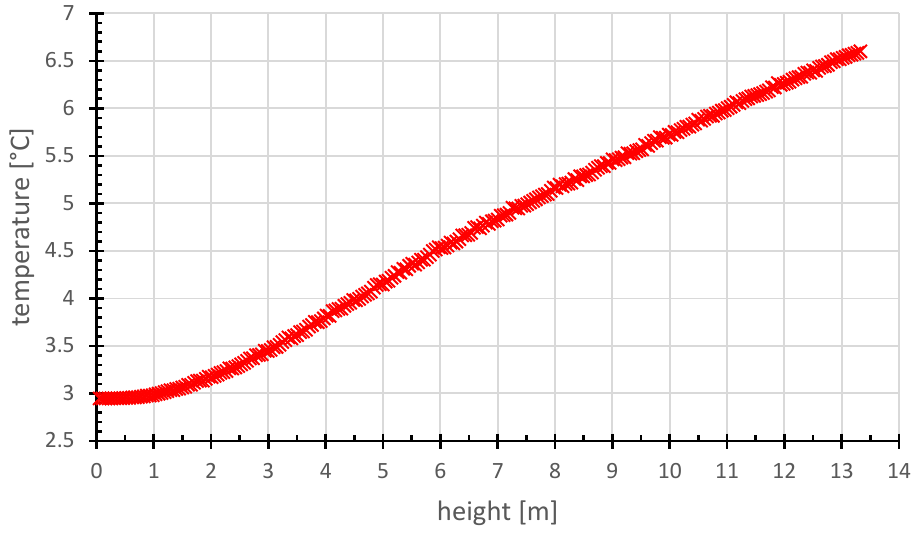
Figure 18. Projection and graph of temperature distribution of air in air gap along façade height in winter extreme.